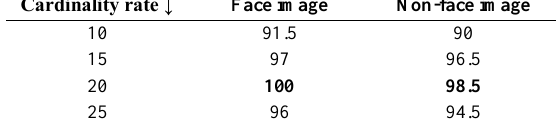
Table 9. Percentage of classification accuracy rate for face/non-face image based on the proposed dictionary- based classifier (MIT database) with GLCM/HOG/LBP/Moment feature vector for different cardinality values.